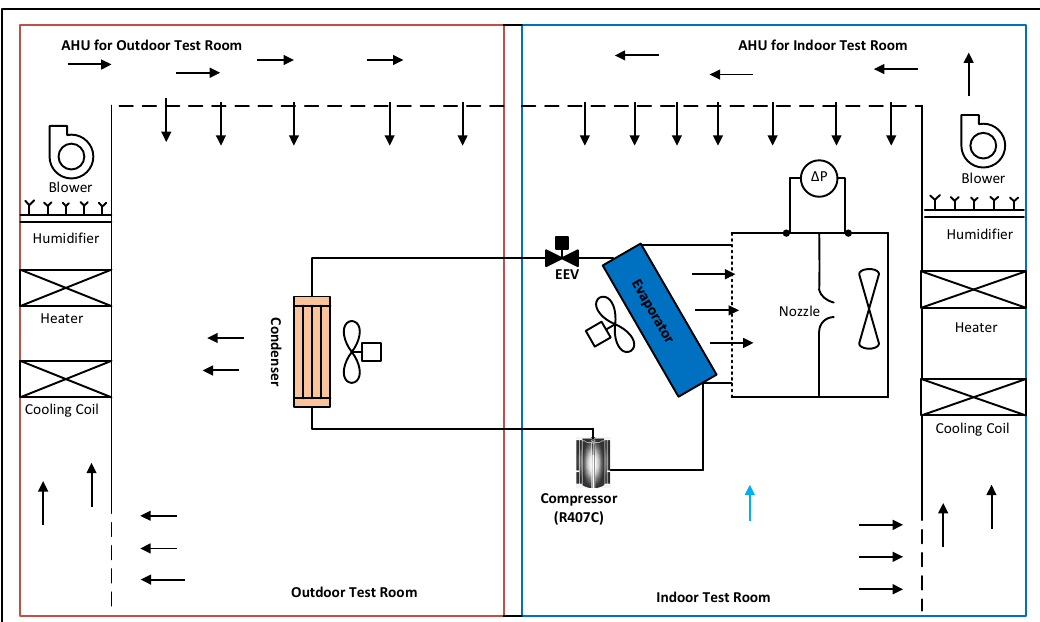
Figure 1. Schematic diagram for conventional cooling system for IDC.